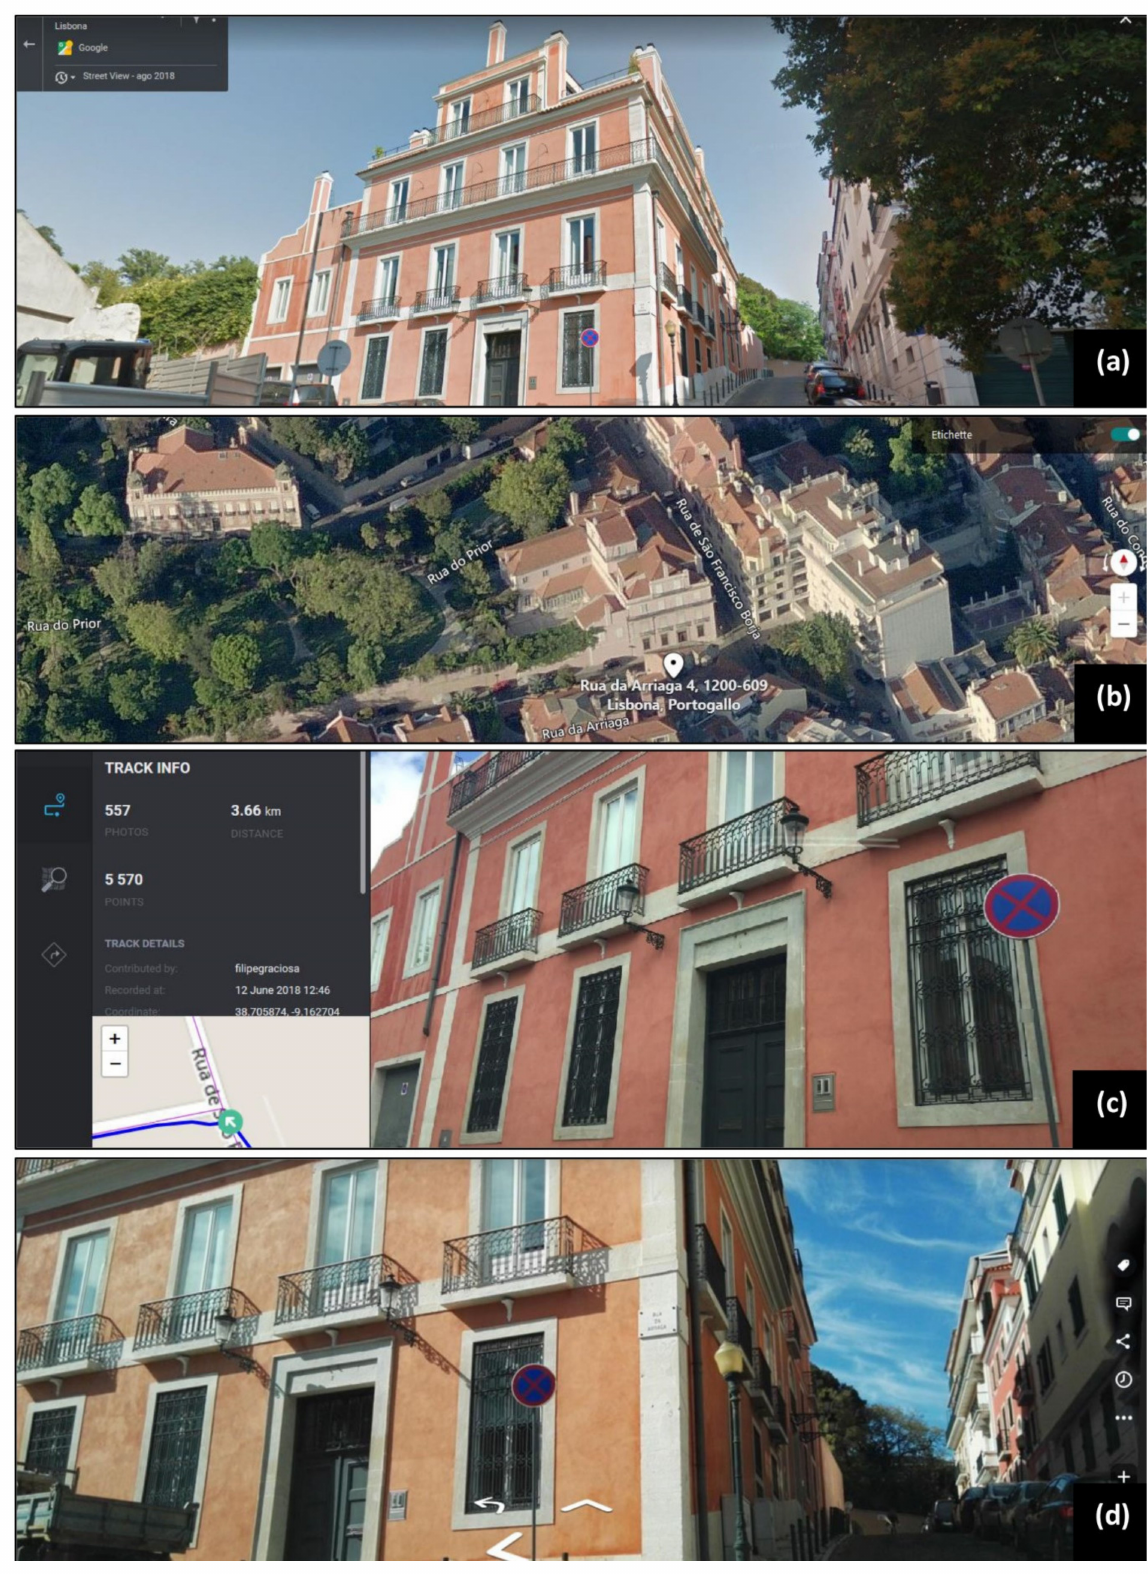
Figure 2. Evaluation of the façade images for assessing the conservation state by using different web platforms: ( a ) Google Maps, ( b ) Bing Maps, ( c ) OpenStreetCam, and ( d )